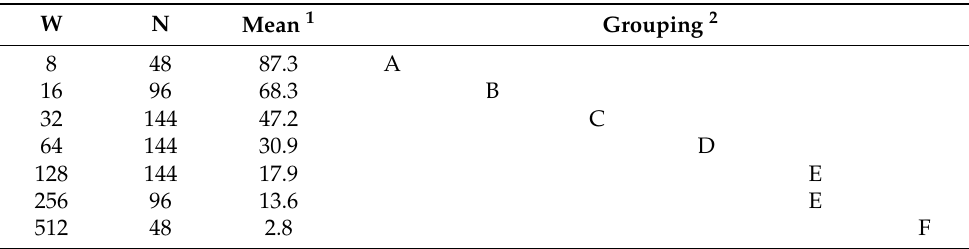
Table 8. Tukey post-hoc analysis for the W in the perceived difficulty. The perceived difficulty was negatively related to W . A smaller W was associated with greater perceived difficulty.